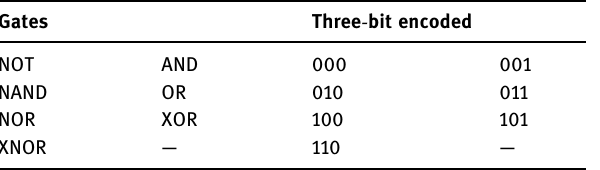
Table 1: Three - bit encoded gates